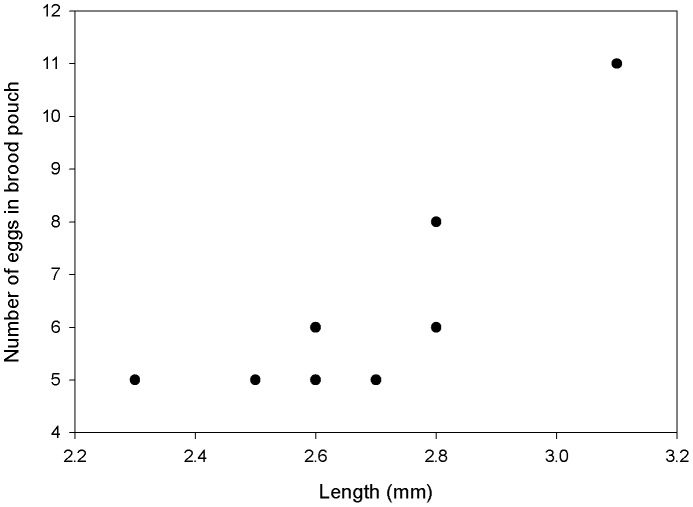
Number of eggs per ovigerous female.